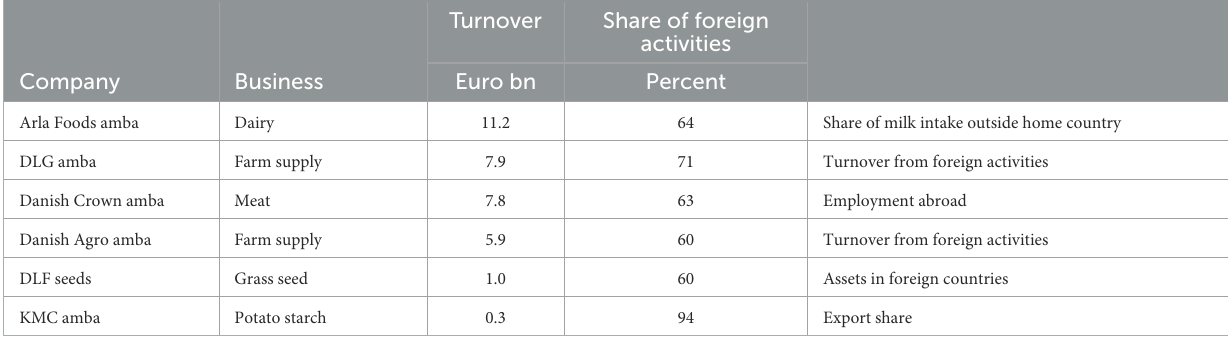
TABLE 2 Top-6 Danish farmer-owned cooperatives: Turnover and foreign